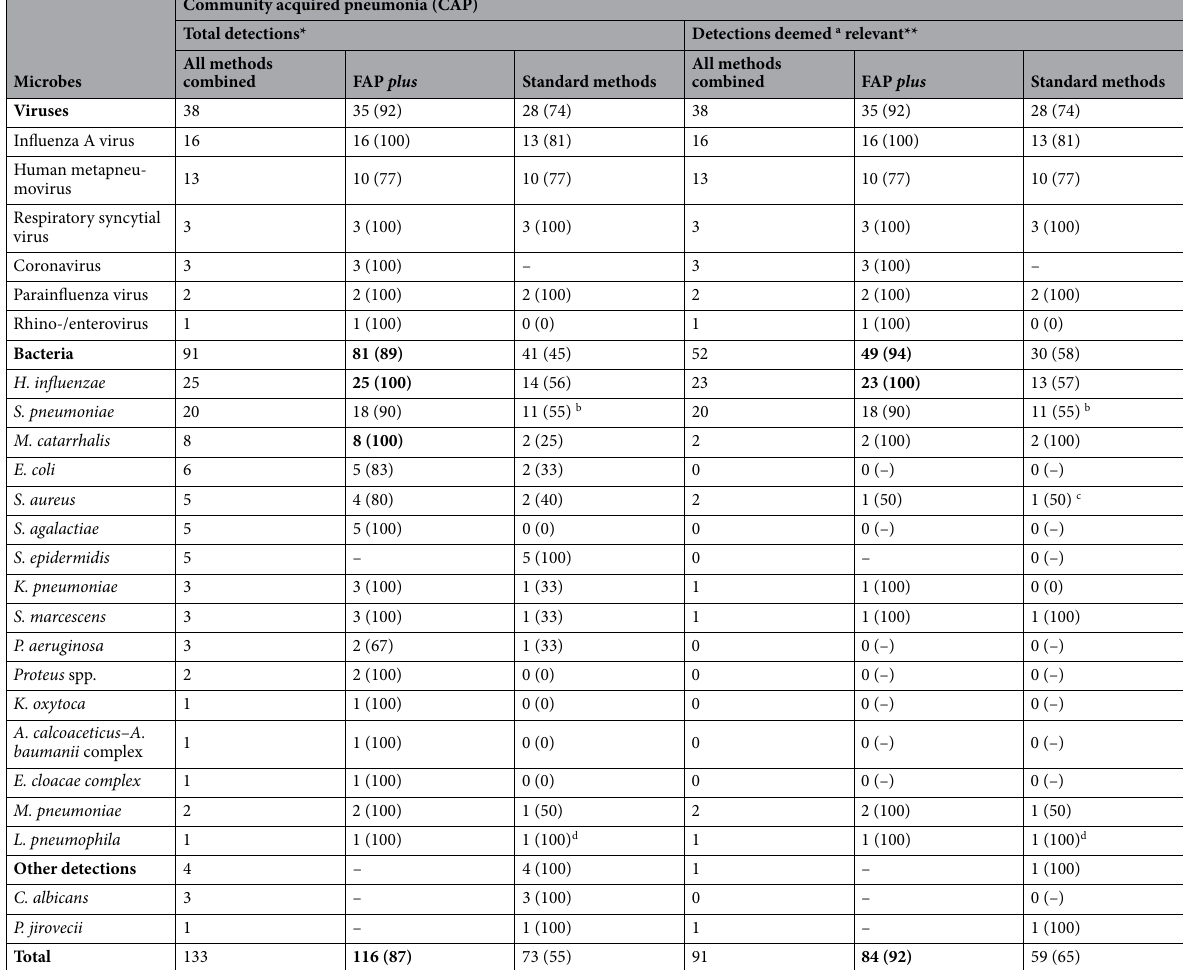
Table 3. Microbiological findings by use of the BioFire FilmArray Pneumonia panel plus versus standard microbiological methods in 72 patients with CAP. Microbiological findings provided by the